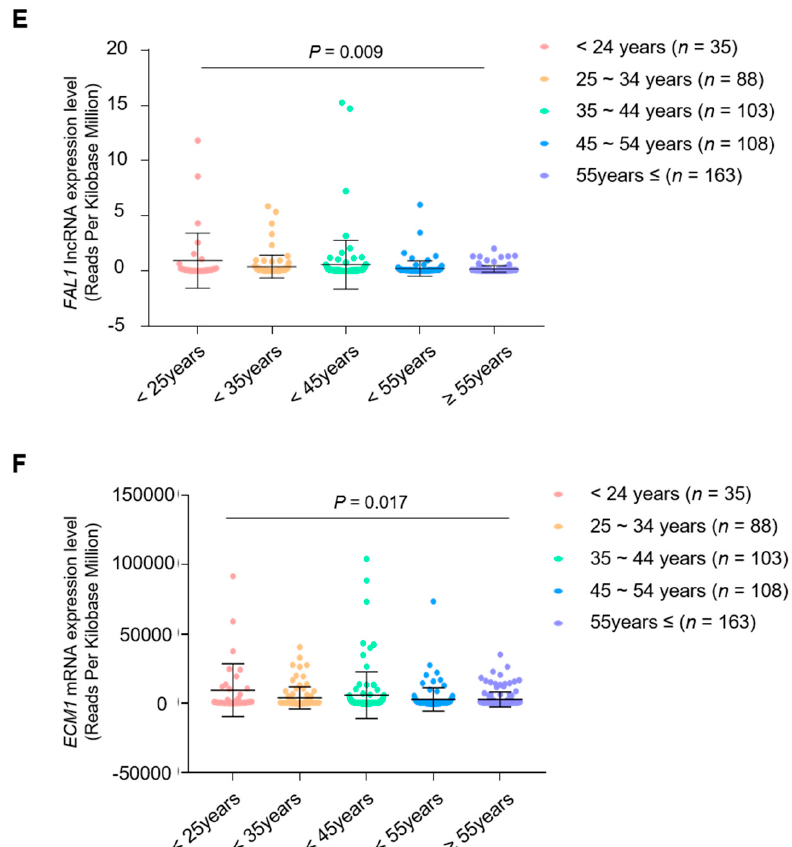
Figure 3. Results of the analysis using the Encyclopaedia of DNA Elements (ENCODE) and FAL1 and ECM1 expression according to patients’ age. ( A ) The TFBS of JUND, c-JUN, and JUN-FOS in the promoter area of ECM1 and FAL1 . ( B ) Expression of the transcriptional target genes of c-JUN according to ECM1 and FAL1 expression status in TCGA THCA. ( C ) Expression of the transcriptional target genes of JUND according to ECM1 and FAL1 expression status in TCGA THCA. ( D ) Selected target gene expressions were identified in GSE127083 RNA-seq dataset for K562 cells treated with JUND - targeted CRISPRi. ( E ) FAL1 expression status according to patients’ age ( F ) ECM1 expression status according to patients’ age. Abbreviations: JUND, junD proto-oncogene; AP-1, transcription factor subunit; JUN, jun proto-oncogene; FOS, fos proto-oncogene; TFBS, transcription factor-binding sites; TCGA, The Cancer Genome Atlas; THCA, thyroid carcinoma; E2F1, transcription factor E2F transcription factor 1; E2F2, transcription factor E2F transcription factor 2; VEGFA, vascular endothelial growth factor A; CCND1 Cyclin D1. Average values were compared using ANOVA, Student’s t -test. In the scatter plots, data are expressed as mean ± SD. All p -values are two-sided. * p < 0.01, ** p < 0.001.